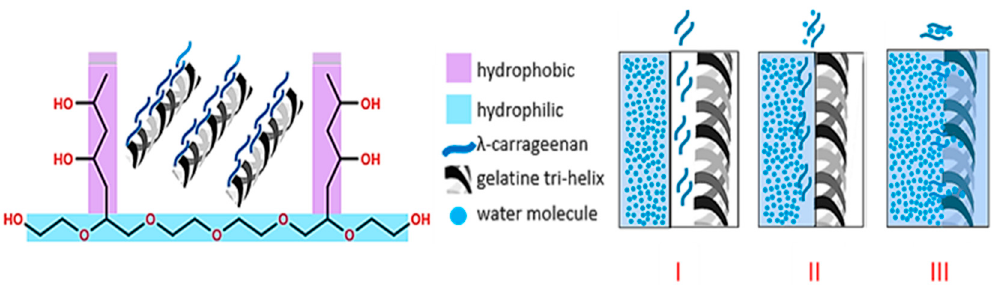
Figure A1. Schematic illustration of Kollicoat ® IR: gelatin: λ -carrageenan ternary network water imbibition theory exhibiting favorable surface coat properties for low friction, low adhesion, and soft texture formation. Phase I hypothesizes that the linear carrageenan chains coat the gelatin triple helix because gelatin possesses numerous relative hydrophobic amino segments that pair with carrageenan’s backbone. The blending of Kollicoat is believed to induce the gelatin: λ -carrageenan complex to associate with polyvinyl alcohol chains that are less hydrophilic than polyethylene glycol. Phase II shows that during water contact, carrageenan molecules readily bond with water molecules, thus resulting in phase III where intricate inter- and intra-hydrogen bonding creates a passage into gelatin’s triple helix that promotes extensive synergistic swelling.